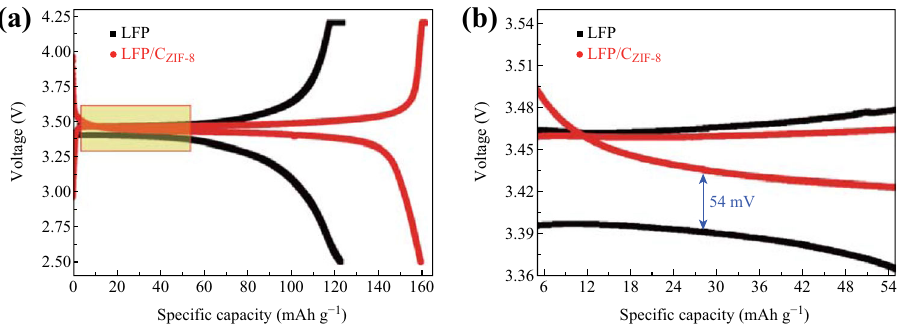
Fig. 3 a The first charge and discharge curves of cathodes between 2.5 and 4.2 V at 0.1C. b The enlarged figure remarked in a . The range of voltage is between 3.36 and 3.55 V, the range of specific capacity is between 5.0 and 55.0 mAh g - 1 . The distance between the voltage platforms of two discharge curves is about 54 mV